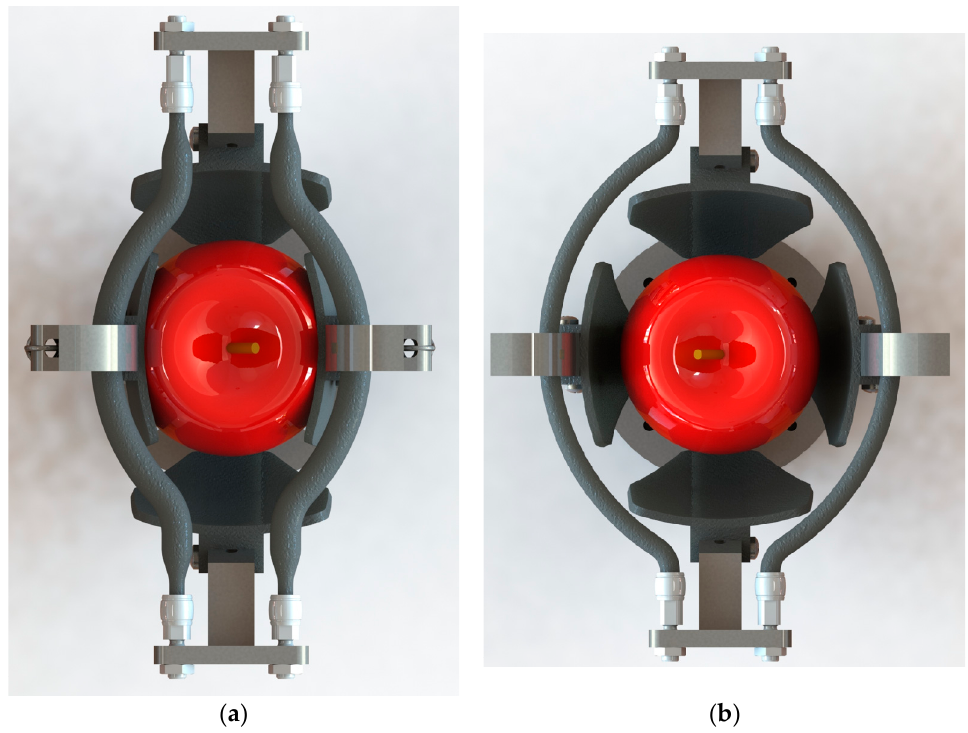
Figure 2. Top view of the 3D model for the proposed harvesting gripper in: ( a ) activated state; ( b ) deactivated state.